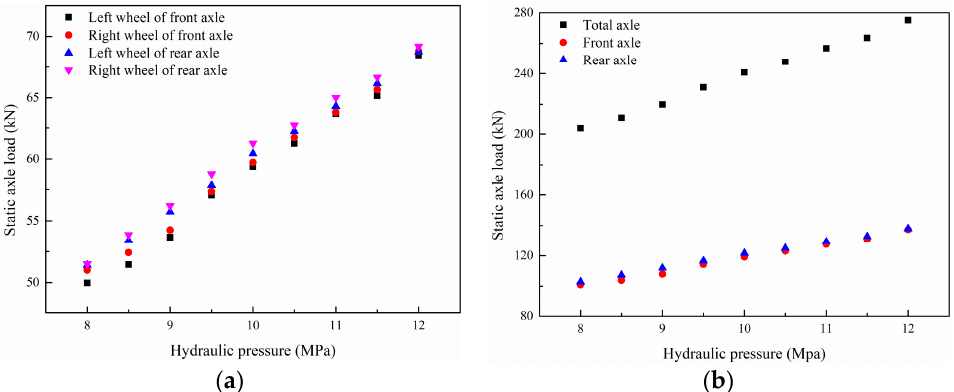
Figure 7. Relation between the hydraulic pressure and static axle load. ( a ) Load of each tire. ( b ) Each